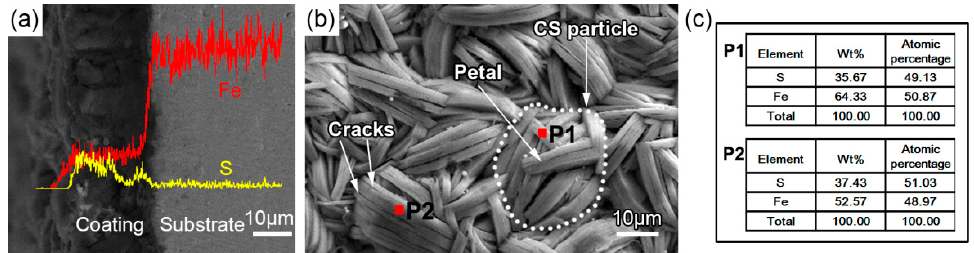
Figure 3. Energy dispersive spectrometry (EDS) line scans ( a ) and point scans ( b ) showing element distribution and content. ( c ) Is the quantitative analysis result of the elements of the scanning points in (b).